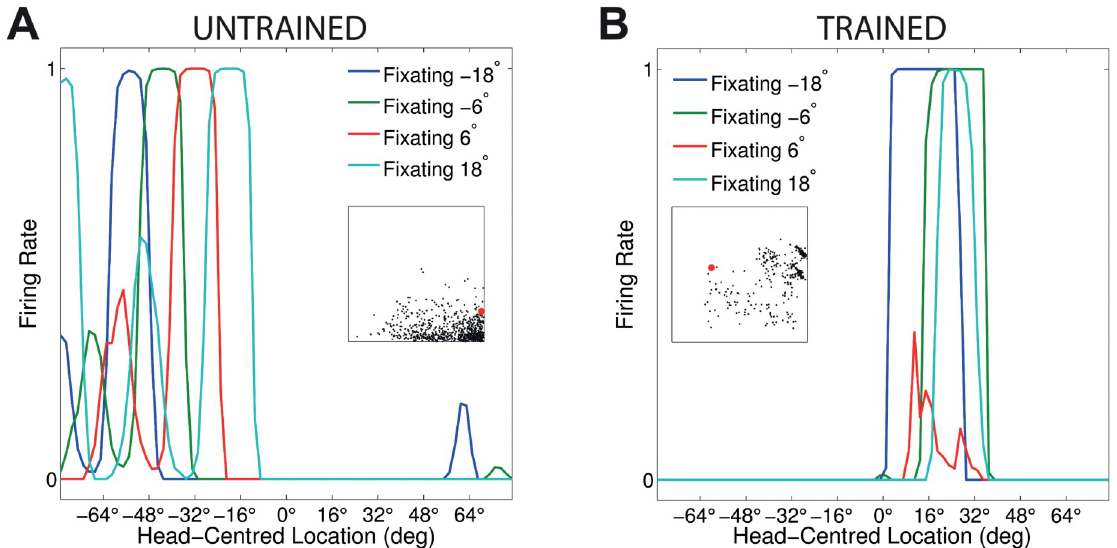
Fig 18. Simulation results showing the firing rate responses of a model incorporating a population of monotonic modulated input neurons trained with the modified learning rule 19: Current postsynaptic trace with anti-Hebbian learning. The figure shows the firing rate responses of output neuron #328 before training (A) and after training (B) during testing for four different eye-positions: − 18˚, − 6˚, 6˚ and 18˚. Conventions as for Fig 12. The comparison of subplot (A) and subplot (B) shows that the output neuron learned to respond to a specific head-centred location regardless of the eye-position after